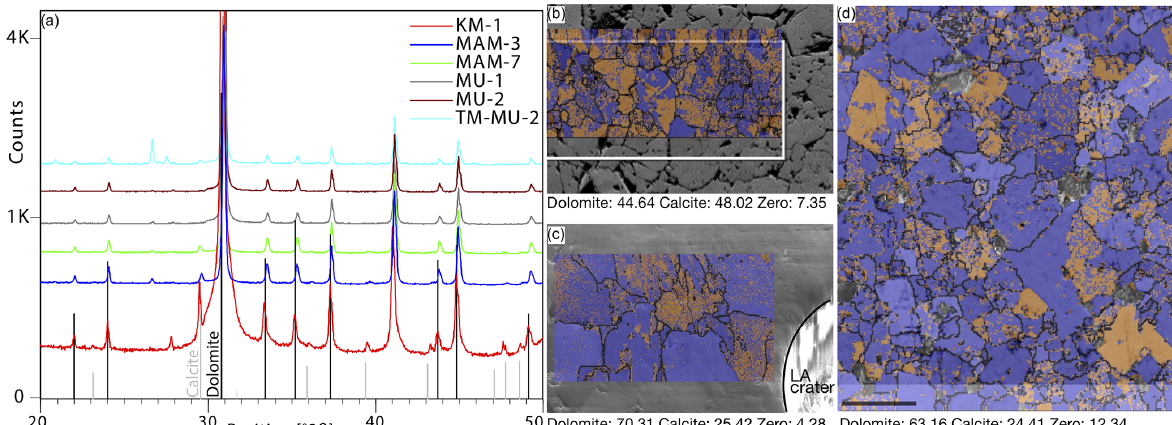
Figure 7. (a) XRD results of the studied samples: all samples are composed entirely of dolomite (peaks above black vertical lines), while some samples show a minor calcite contribution (gray vertical lines). Sample Tm-MU-2 shows additional minor peaks of quartz. EBSD phase maps of samples KM-1 (b) , MU-1 (c) , and MU-2 (d) . Dolomite is marked in purple, calcite in orange, and zero solutions and grain boundaries in